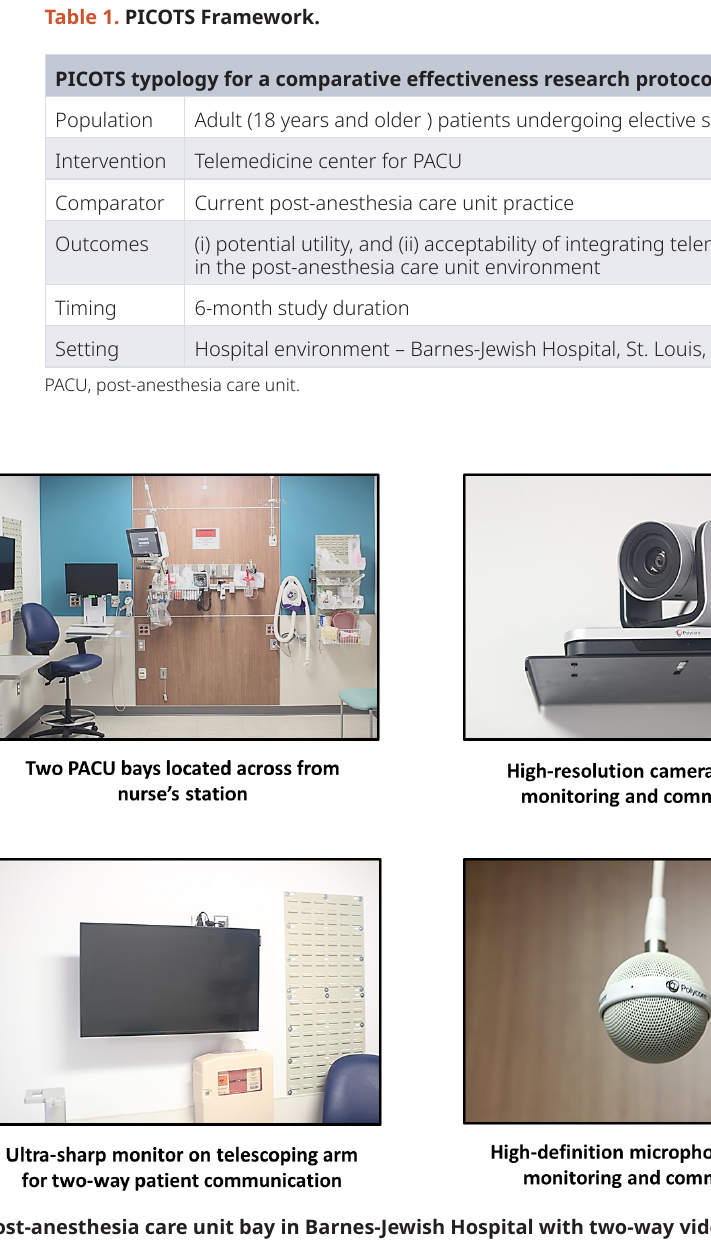
Table 1. PICOTS Framework.